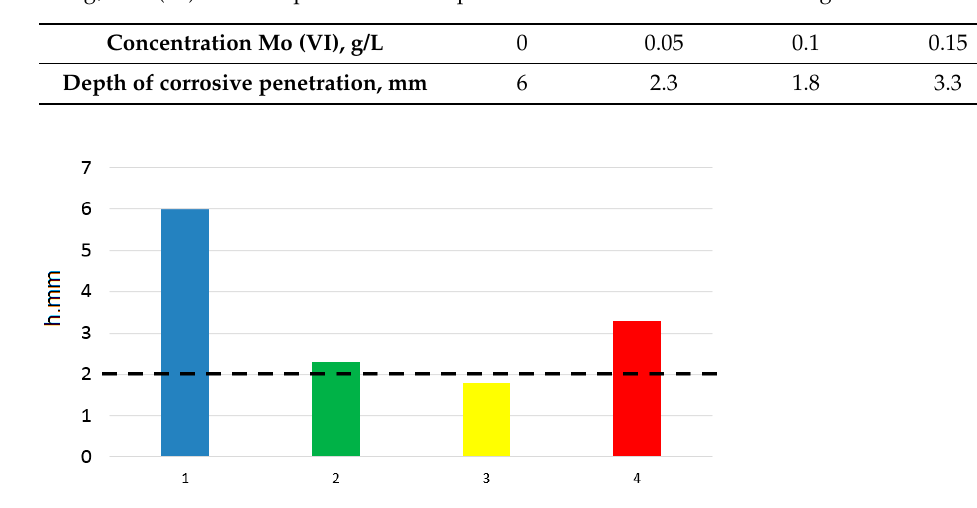
Figure 9. Dependence of the width of the separation of the paintwork from the cuts on concentra- tions of Mo (VI) g/L: ( 1 ) 0; ( 2 ) 0.05; ( 3 ) 0.1; ( 4 ) 0.15 in deposition solution 0.2 g/L Zr (IV) + 0.15 g/L W (VI).